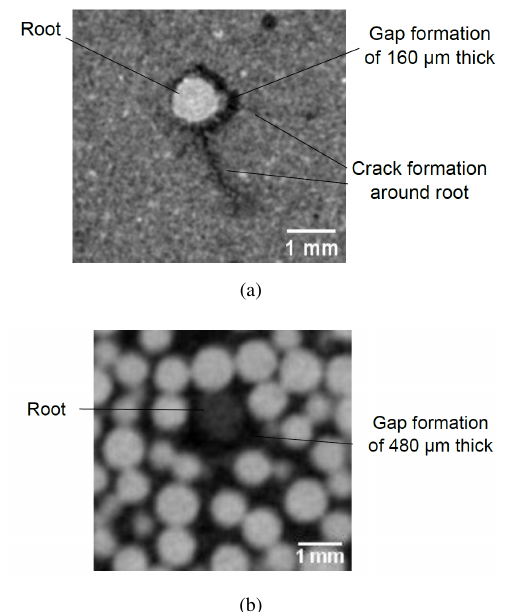
Figure 6. Greyscale images of the soil samples illustrating the soil structure after 7 days of growth. A crack formation radiating from the root surface can be observed for the (a) fine and (b) coarse glass